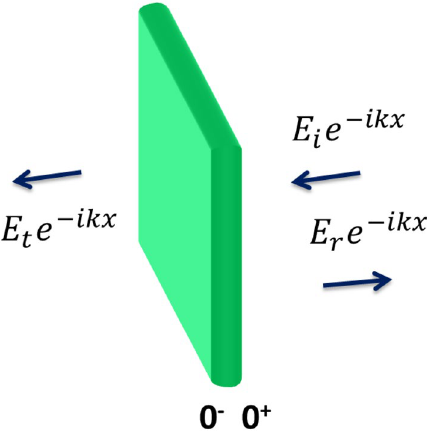
Figure 1. A single non-linear delta function layer.